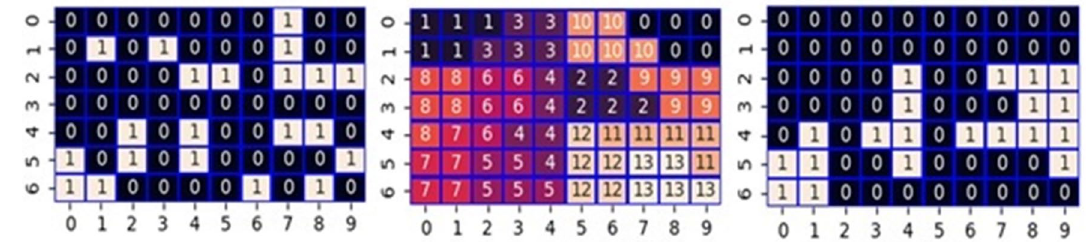
Figure 7. Companies in charge of each delivery destination at preset (left). Calculated correspondence between the delivery destinations and the 14 groups indexed from 0 to 13 (center). The assignment of company to manage new groups